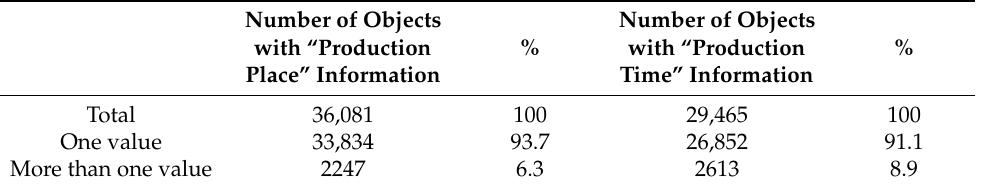
Table 2. Number and percentages of objects with multiple locations and/or multiple time spans,